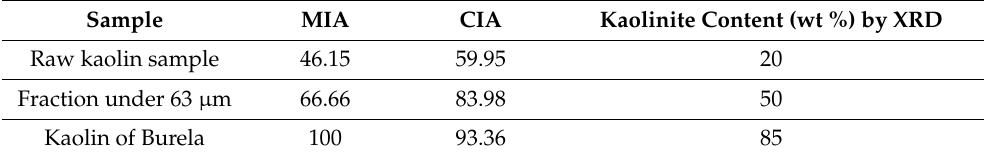
Table 3. Results of mineralogical and chemical characteristics (MIA and CIA parameters) deduced from mineralogical (XRD) and chemical (XRF) analyses of the samples. Sample MIA CIA Kaolinite Content (wt %) by XRD Raw kaolin sample 46.15 59.95 20 Fraction under 63 µ m 66.66 83.98 50 Kaolin of Burela 100 93.36